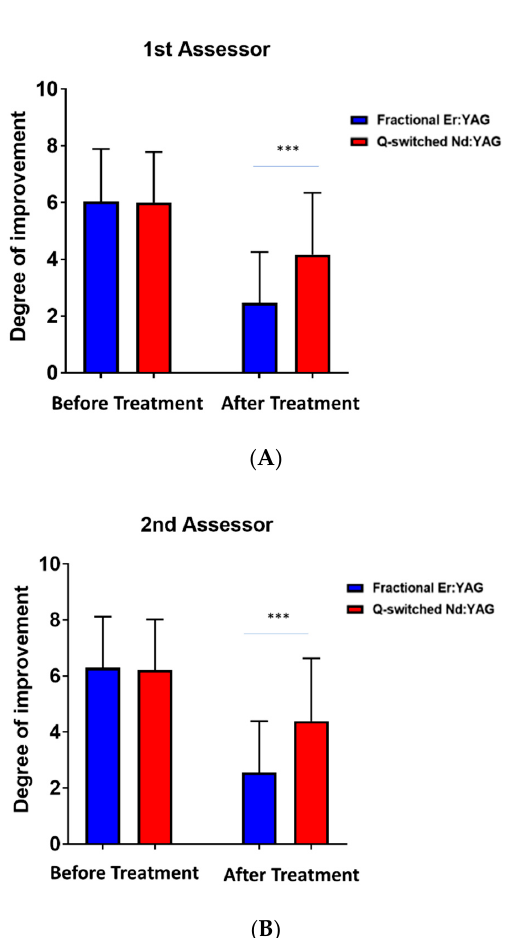
Figure 1. The degree of improvement based on the visual analogue scores of ( A ) the first assessor before and after treatment between the Q-switched Nd: YAG (1064 nm) and fractional Er: YAG (2940 nm) lasers and ( B ) the second assessor before and after treatment between the Q-switched Nd: YAG (1064 nm) and fractional Er: YAG (2940 nm) lasers. *** p <